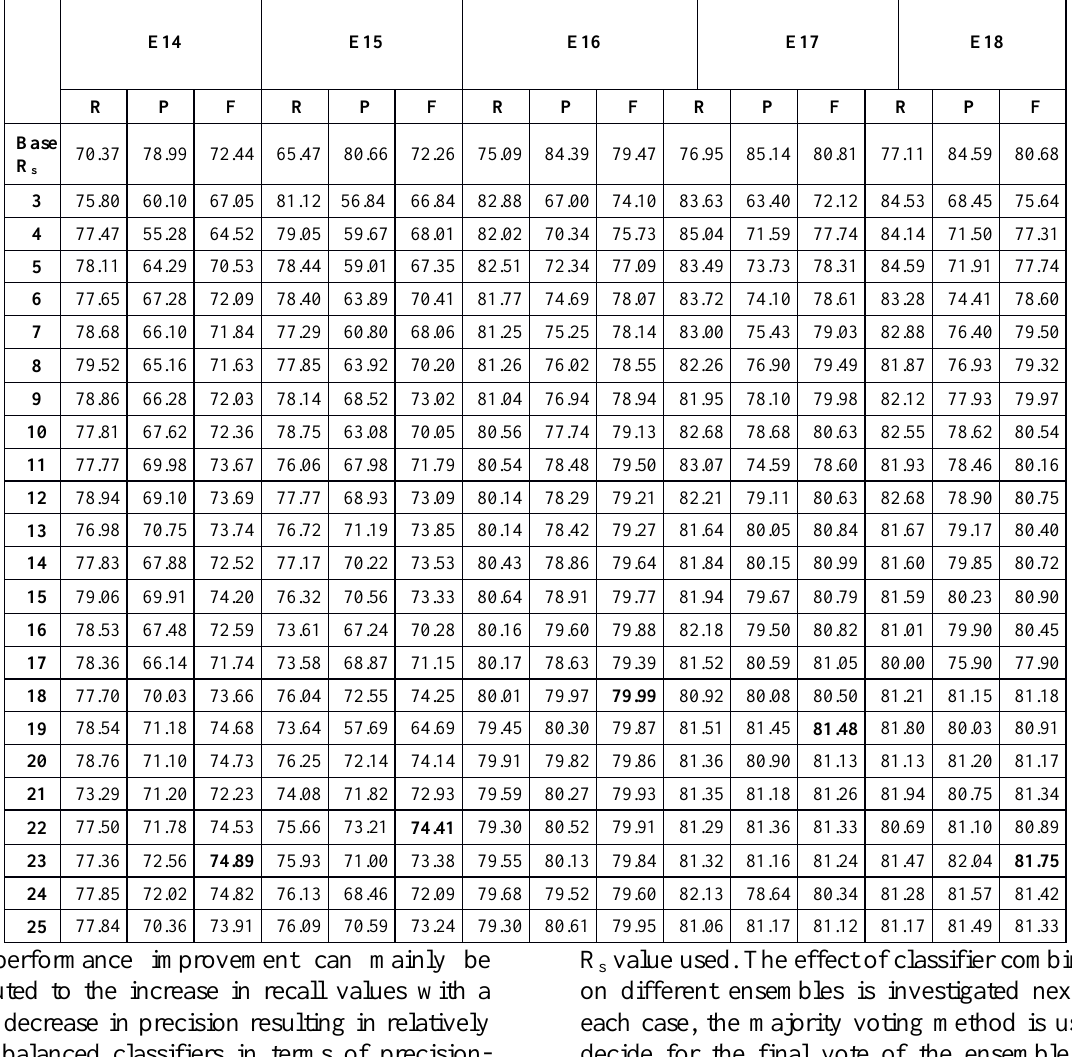
Table 4. Performance of five selected classifiers with different sampling ratios R s on validation data.